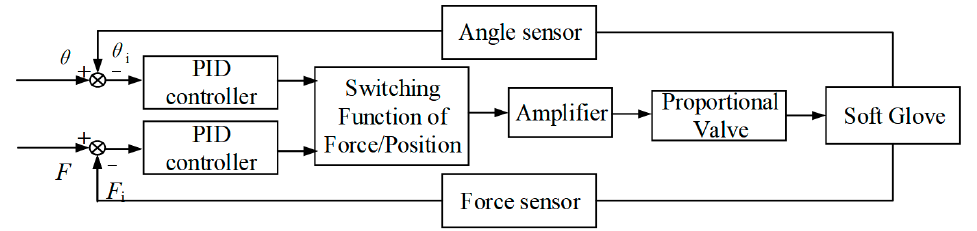
Figure 20. Control strategy for soft rehabilitation